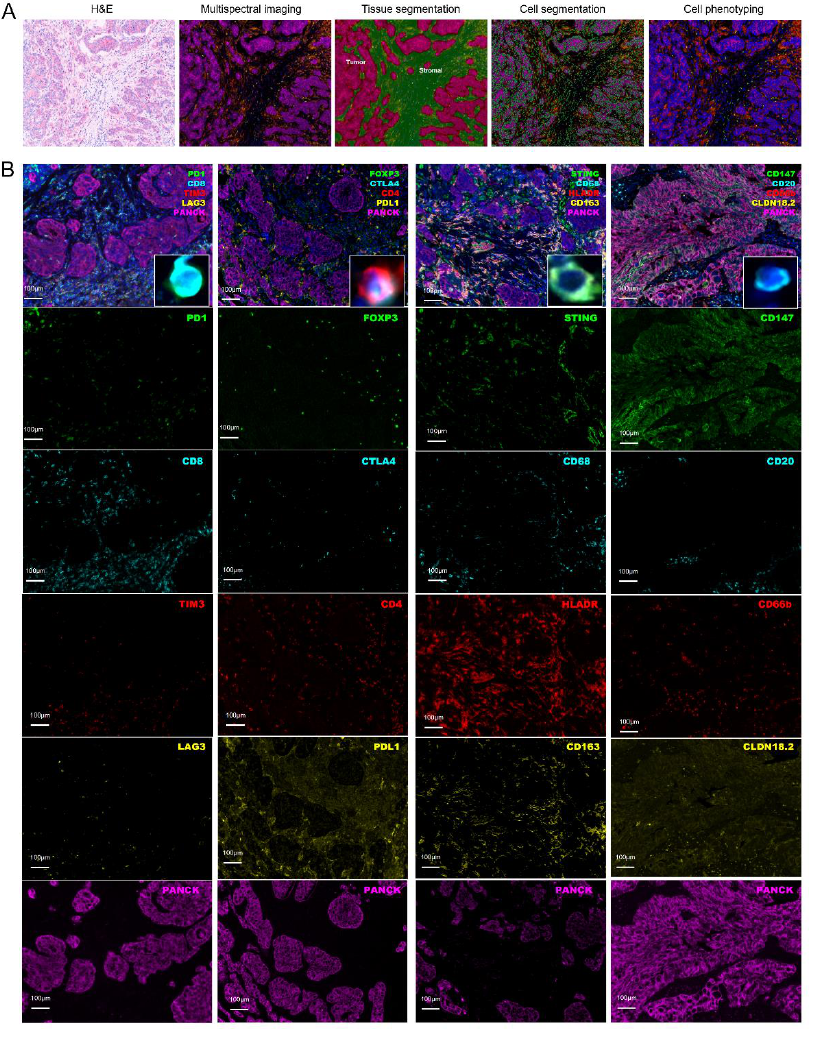
Figure 1. ( A ) Procedure for quantifying the densities of immune cells in FFPE samples with m-IHC staining. ( B ) Examples of m-IHC staining to visualize the expression of CD8, PD-1, TIM3, LAG3, CD4, FoxP3, CTLA4, PD-L1, CD68, CD163, HLADR, STING, CD20, CD66b, CD147, CLDN18.2 in primary gastric cancer microenvironment. The density of exhausted CD8 + T cell was significantly positively correlated with NLR ( p = 0.029), PLR ( p = 0.007), and SII ( p = 0.047). In detail, higher NLR was associated with higher CD8 + LAG3 + PD1 + ( p = 0.015), higher CD8 + LAG3 + PD1 - ( p = 0.011), higher CD8 + LAG3 − PD1 + ( p = 0.039), higher CD8 + PD1 − TIM3 + ( p = 0.010), and higher CD8 + LAG3 + PD1 + TIM3 − ( p = 0.005). Inversely, higher LMR was associated with lower CD8 + LAG3 + PD1 + ( p = 0.045), lower CD8 + LAG3 + PD1 − ( p = 0.023), lower CD8 + PD1 − TIM3 + ( p = 0.031), and lower CD8 + LAG3 + PD1 + TIM3 − ( p = 0.012). Furthermore, PLR was associated with higher CD8 + LAG3 + PD1 − ( p = 0.022), higher CD8 + LAG3 − PD1 + ( p = 0.016), higher CD8 + LAG3 − PD1 − ( p = 0.014), higher CD8 + PD1 − TIM3 + ( p = 0.004), and higher CD8 + LAG3 - PD1 + TIM3 − ( p = 0.026). SII was associated with higher CD8 + LAG3 + PD1 − ( p = 0.029), higher